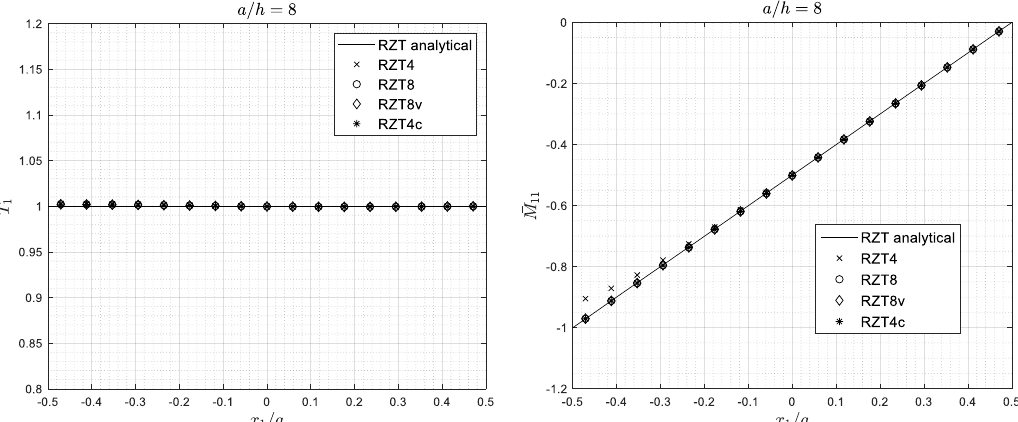
Figure 16. Cantilever thick sandwich (S) square plate under uniform edge transverse pressure (C2). Transverse shear force and bending moment distribution.